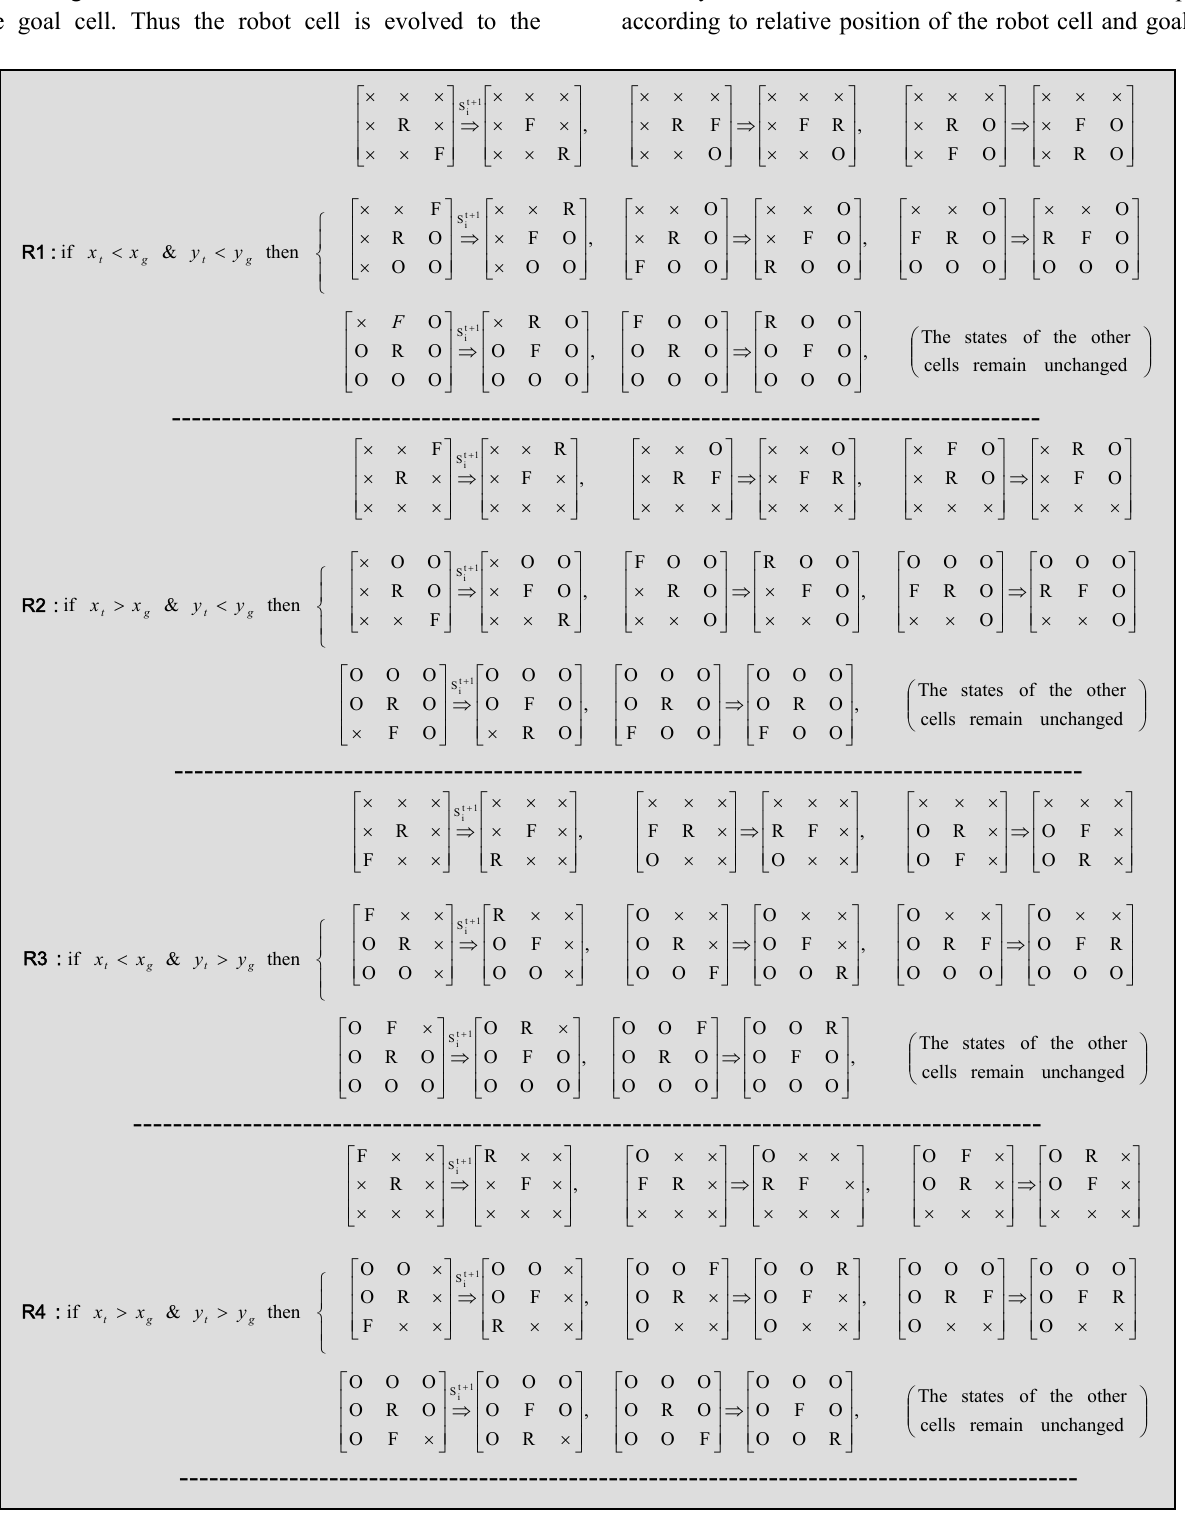
Fig. 3. Rules of the path planner cellular automata. At each time step t only one of the rules is active. In these rules, (x t ,y t ) is position vector of robot at time t and (x g ,y g ) is the position vector of goal cell. Symbol × denotes the cells those states do not important at time step t